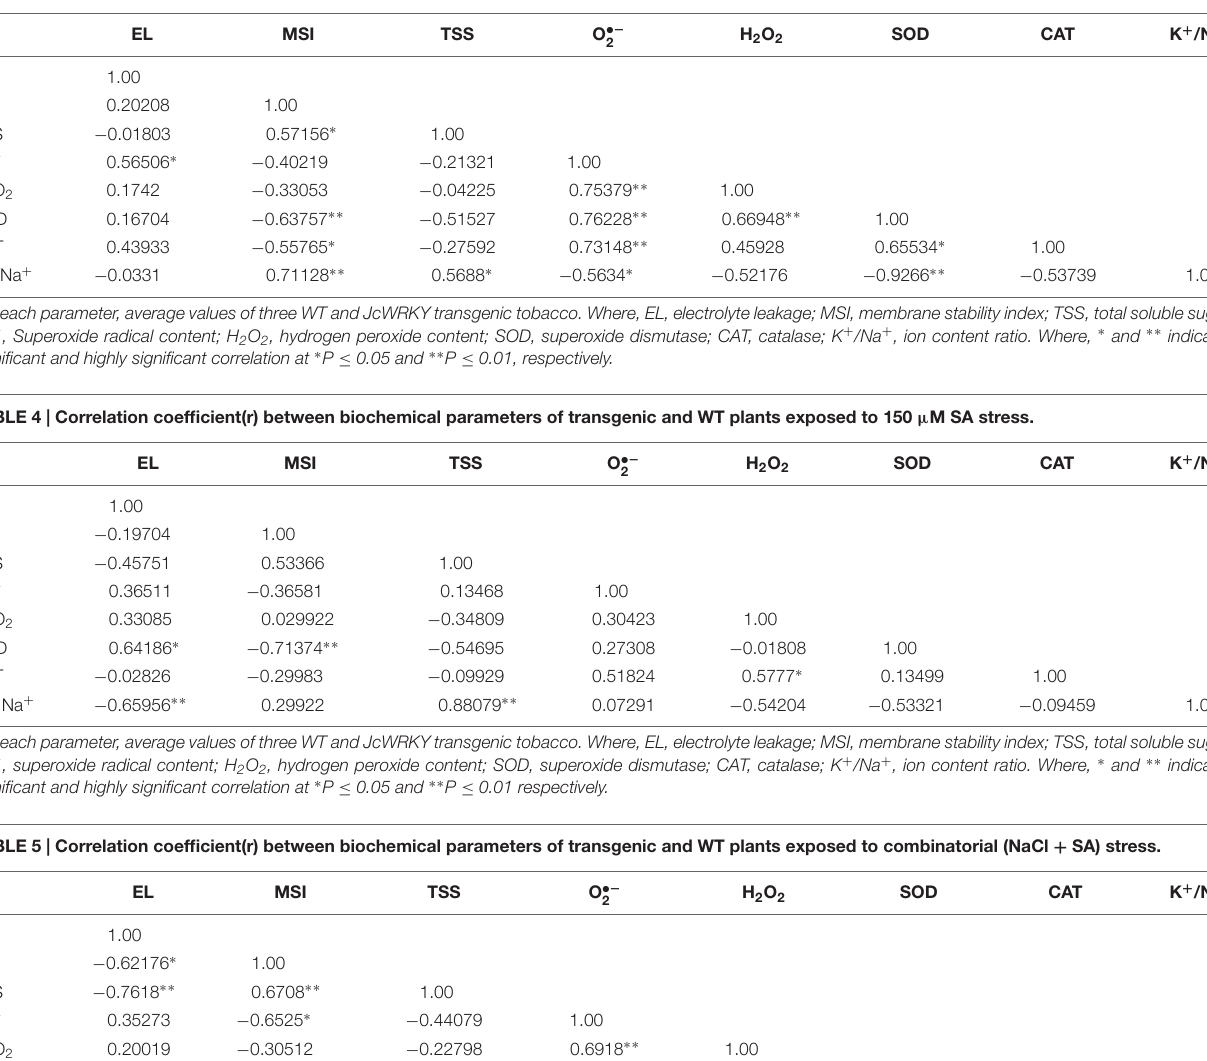
TABLE 3 | Correlation coefficient(r) between biochemical parameters of transgenic and WT plants exposed to 200 mM NaCl stress. EL MSI TSS O •− H 2 O 2 SOD CAT K + /Na + 2